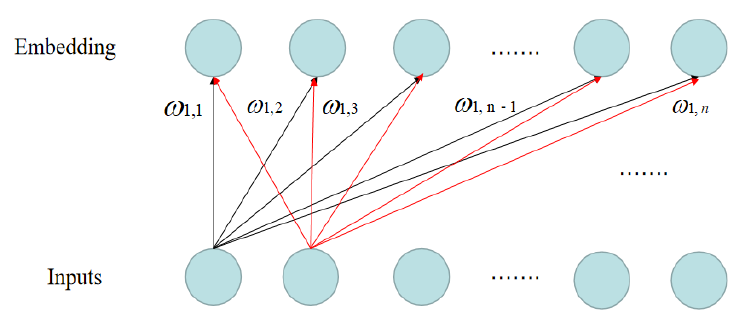
Figure 3. Embedding process for multidimensional variables.